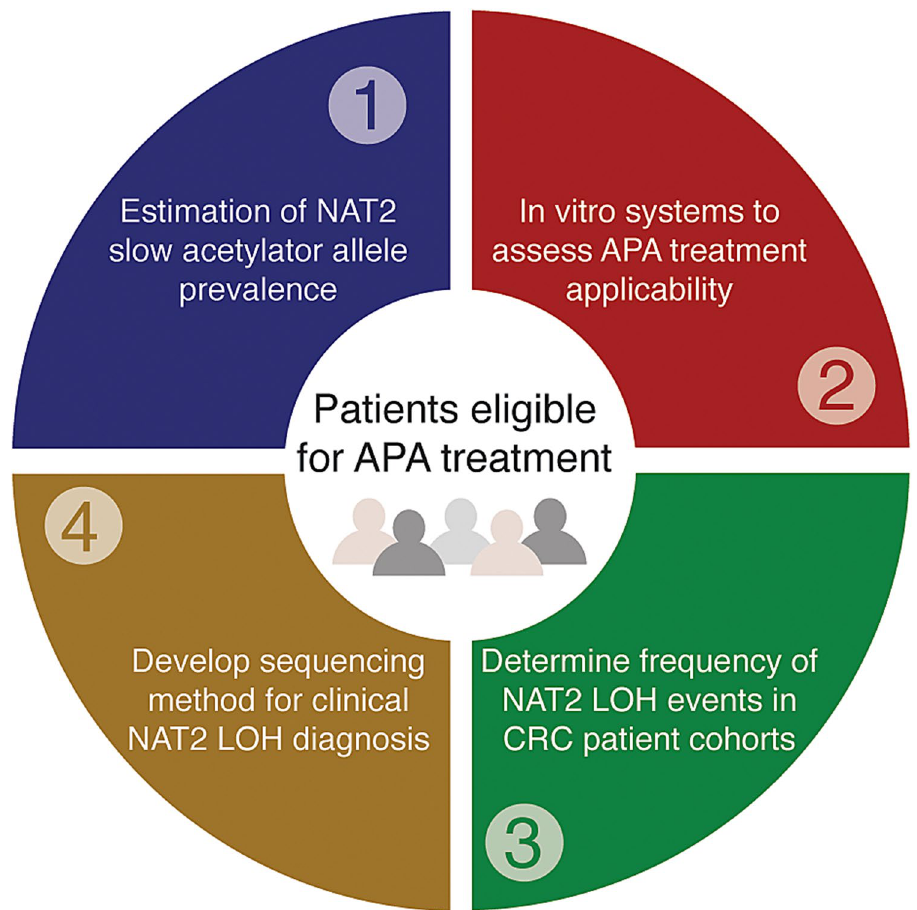
Figure 1. Workflow for the identification of eligible patients for allele-selective chemotherapy with